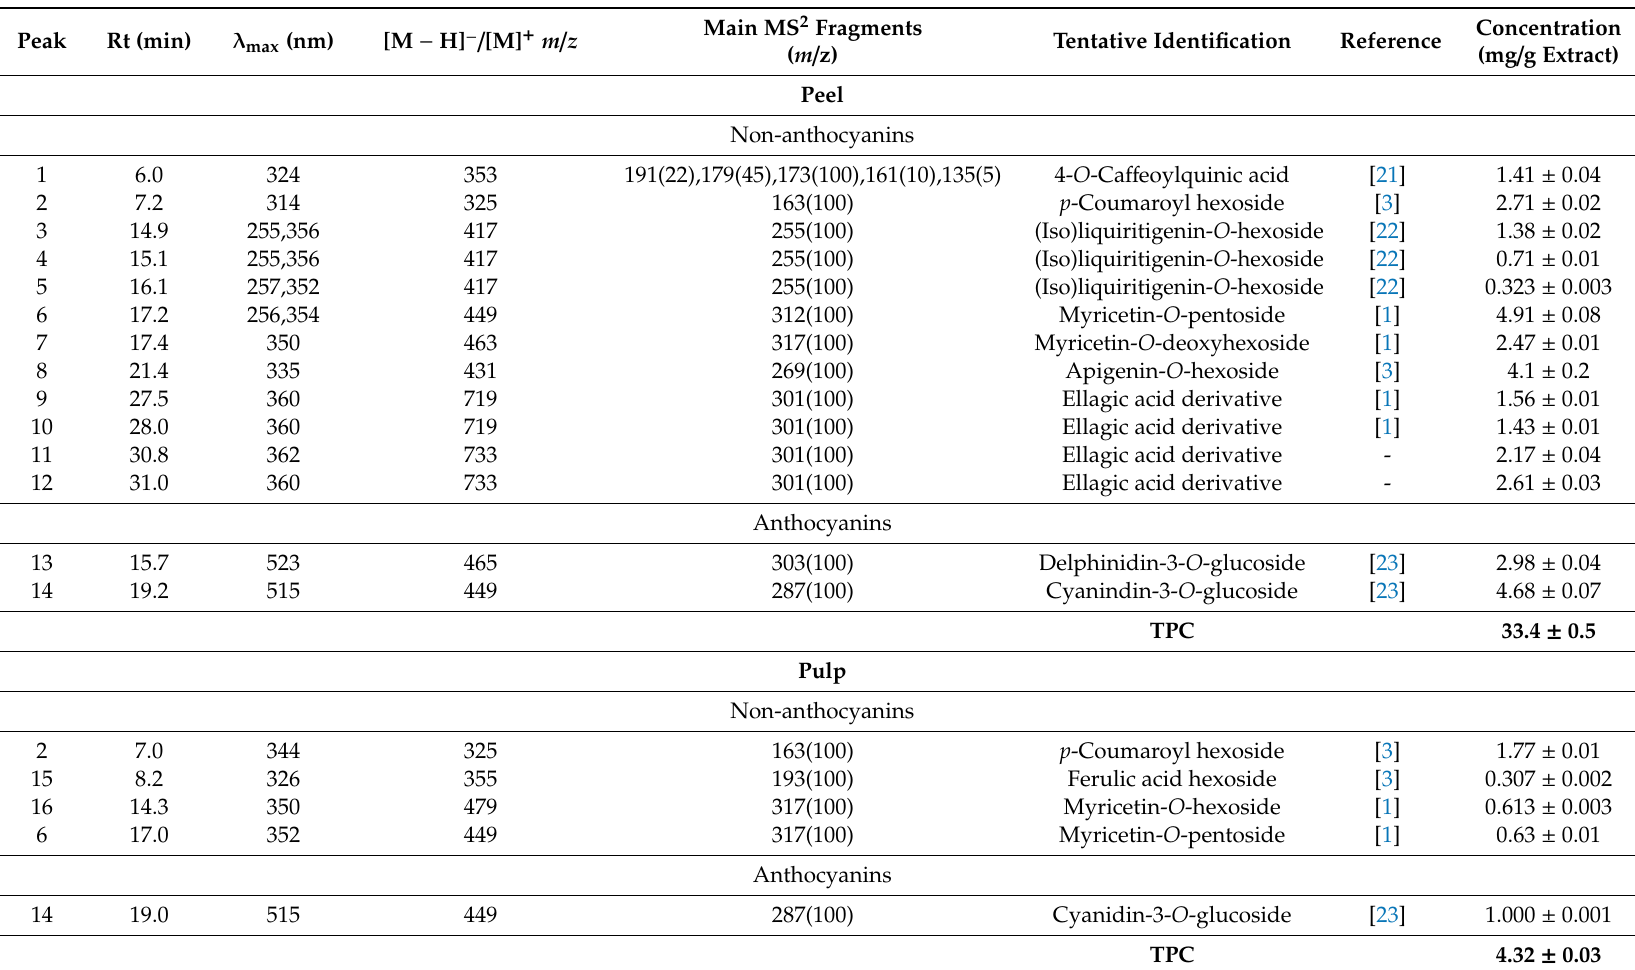
Table 1. Retention time (Rt), wavelengths of maximum absorption in the visible region ( λ max ), mass spectrometric data, and tentative identification of phenolic compounds of the hydroethanolic extracts of the distinct parts camu-camu fruit investigated in the present work, namely peel, pulp, and seed. Peak Tentative Identification